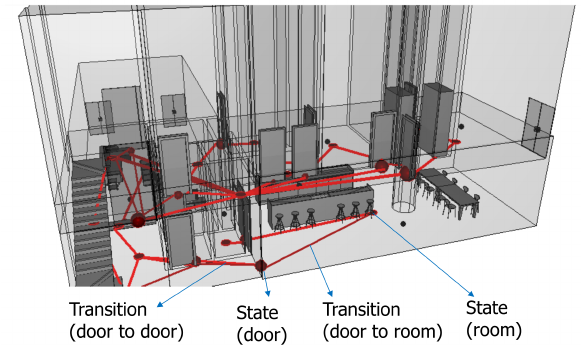
Figure 5. Example of subdivision result of a residence building.